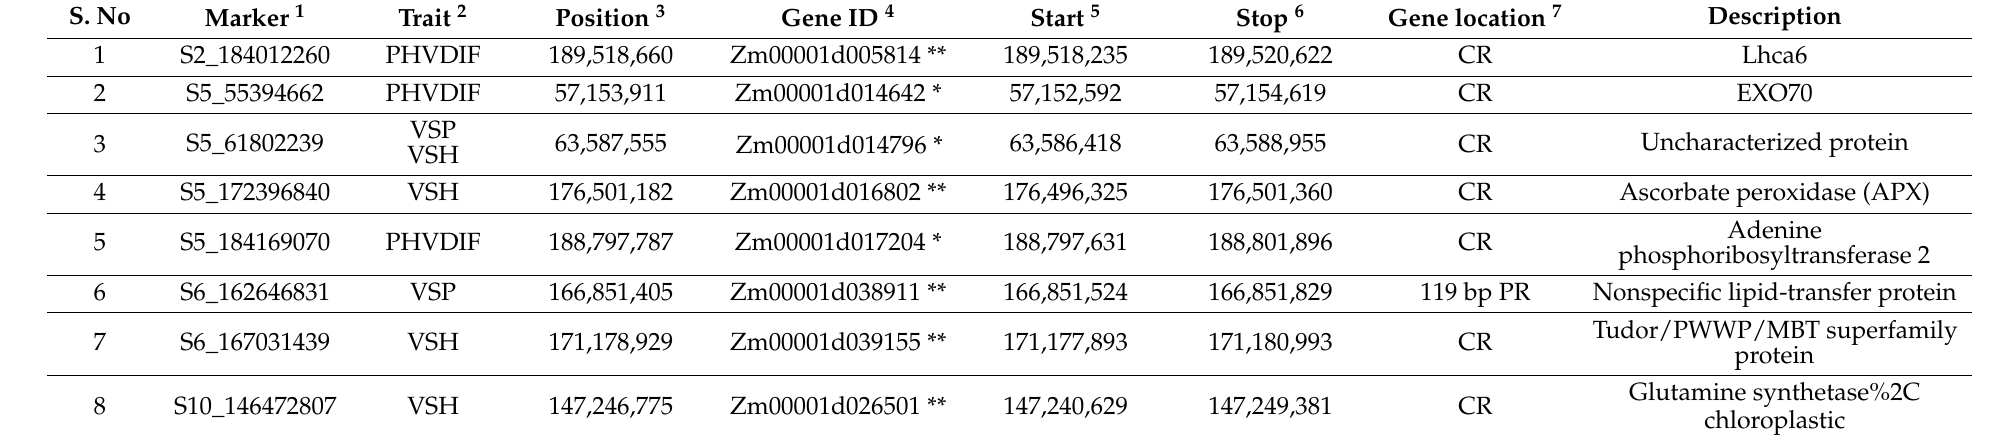
Table 3. List of candidate genes with significant markers within the coding region of the gene and in the promoter